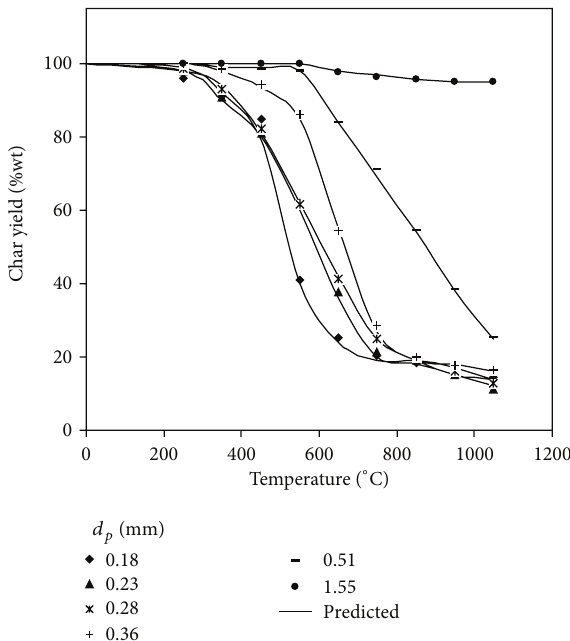
Figure 6: Char yields for palm shell pyrolysis in a free-fall reactor at different pyrolysis temperatures for various particle sizes (N 2 flow rate is 200 cm 3 /min).